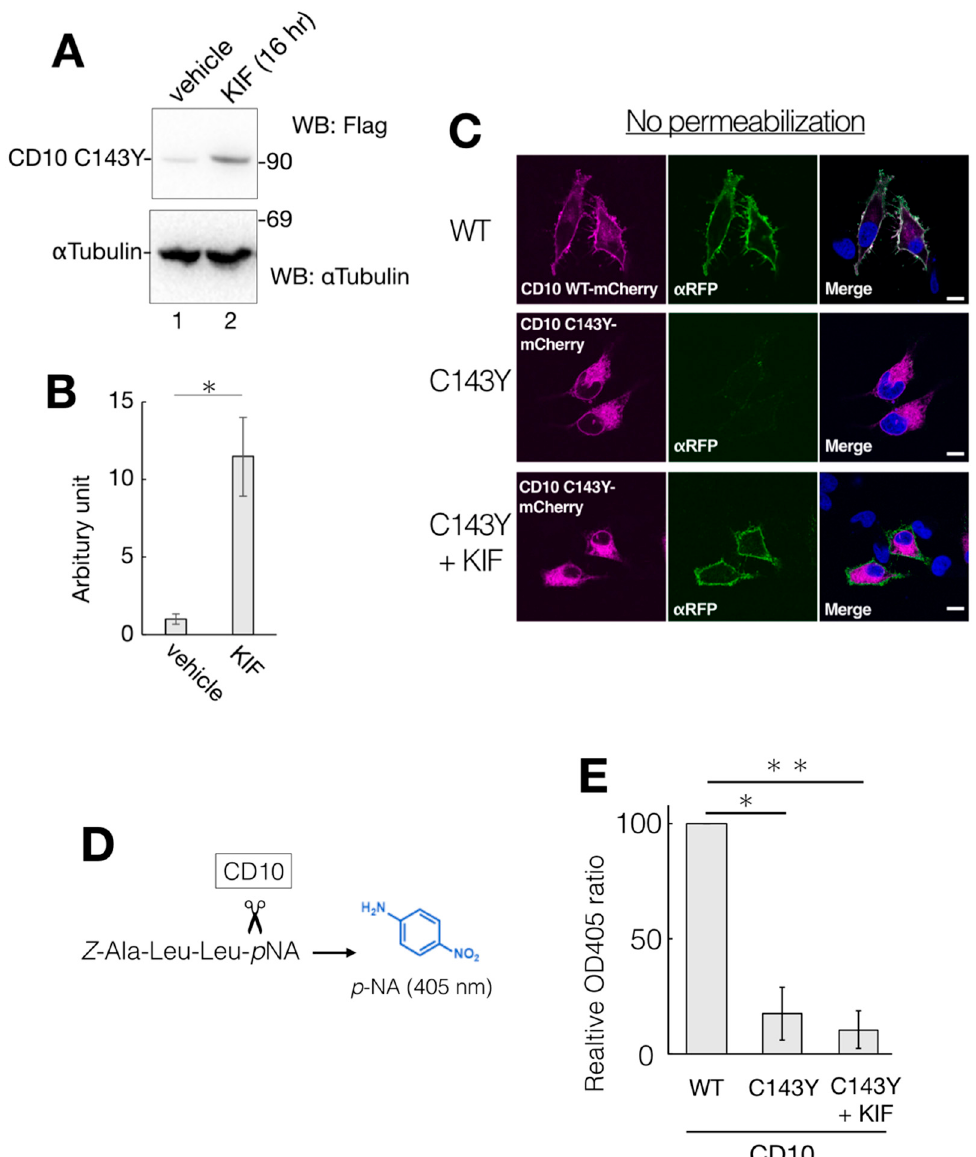
Figure 7. Partial recovery of CD10 C143Y by KIF treatment. ( A ) HeLa cells-expressed CD10 C143Y were treated with vehicle or 100 µ M KIF for the last 16 h of total transfection time. After lysis, supernatants of cell lysates were resolved and immunoblotted with anti-Flag or anti- α Tubulin. ( B ) quantification of anti-Flag immunoblotting from A. Error bars represent mean ± standard deviation for three independent experiments. Asterisks indicate statistical significance (*; p < 0.01) by Student’s t test. ( C ) recovery of cell surface expression of CD10 C143Y by KIF treatment. Transfected HeLa cells with mCherry-tagged WT or C143Y CD10 plasmids with or without KIF were fixed with PFA and immunostained with anti-red fluorescent protein (RFP) antibody without plasma membrane permeabilization. Scale bars represent 10 µ m. ( D ) overview of endopeptidase assay of CD10. A peptide substrate Z -Ala-Leu-Leu- p NA was cleaved next to the second Leu by CD10. The enzyme activity was measured by liberated p NA, which exhibits an absorption maximum at 405 nm. ( E ) C143Y showed less enzymatic activity than WT even under 16 h KIF treatment. Transfected HeLa cells with indicated vectors were subjected to CD10 enzyme activity assay, as described in Materials and Methods. Error bars represent mean ± standard deviation for three independent experiments. Asterisks indicate statistical significance (*; p < 0.01, **; p < 0.01) by Student’s t